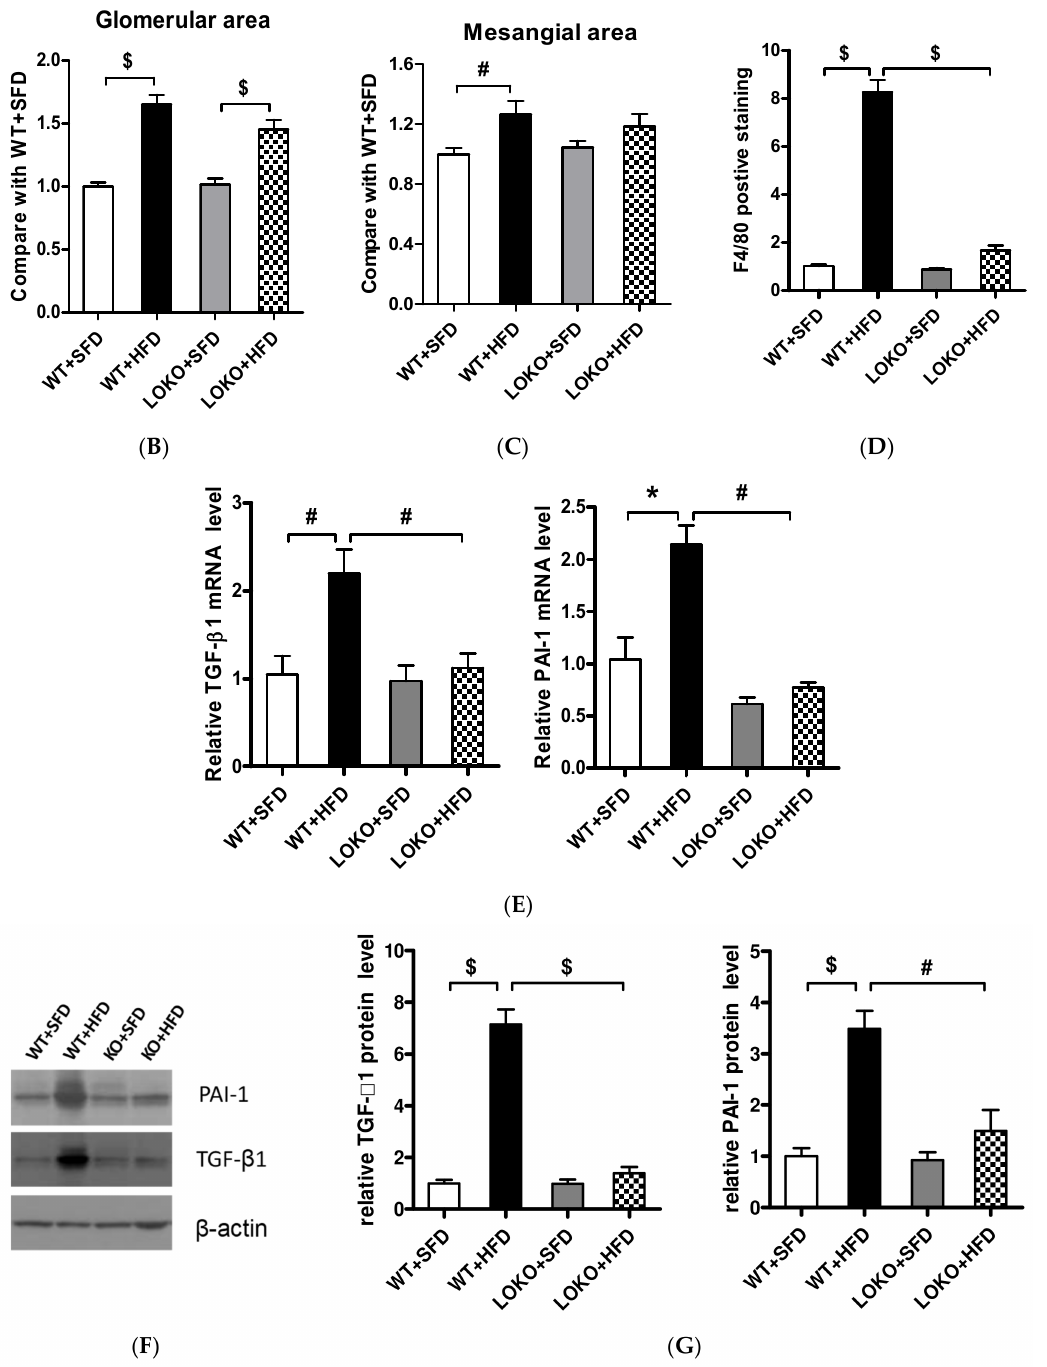
Figure 8. Obesity related glomerular hypertrophy, mesangial matrix expansion, and macrophage infiltration in glomeruli were less detected in 12/15-LO knockout obesity mice. ( A ) Representative images of PAS and F4/80 staining in experimental mouse glomeruli. Measurement of glomerular area ( B ), extra cellular matrix (ECM) accumulation ( C ), and F4/80-positive macrophage ( D ) in renal cortex from obesity (HFD) and control (SFD) WT and LOKO mice. Data represented as mean ± SEM. # p < 0.01, $ p < 0.001 vs. WT + SFD or LOKO + SFD. ( E ) Profibrotic genes of PAI-1 and TGF- β 1 mRNA expression in renal cortical tissues were detected by RT-qPCR. ( F ) Total protein from kidneys was extracted and immunoblotted with indicated antibodies. ( G ) Band density of WB was detected and is represented as fold over WT + SFD control (mean ± SEM, n = 3. # p < 0.01, $ p <